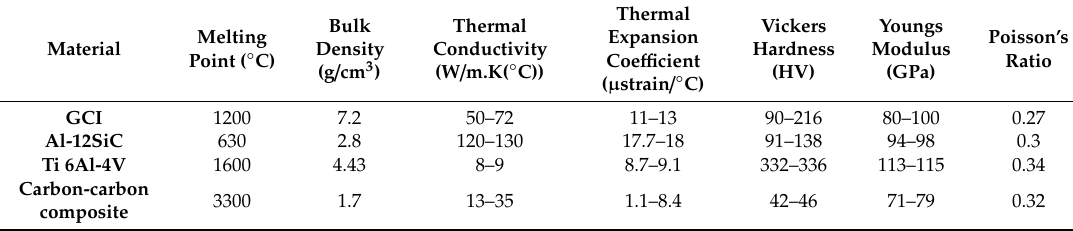
Table 1. Mechanical and thermal properties of promising brake disc materials at room